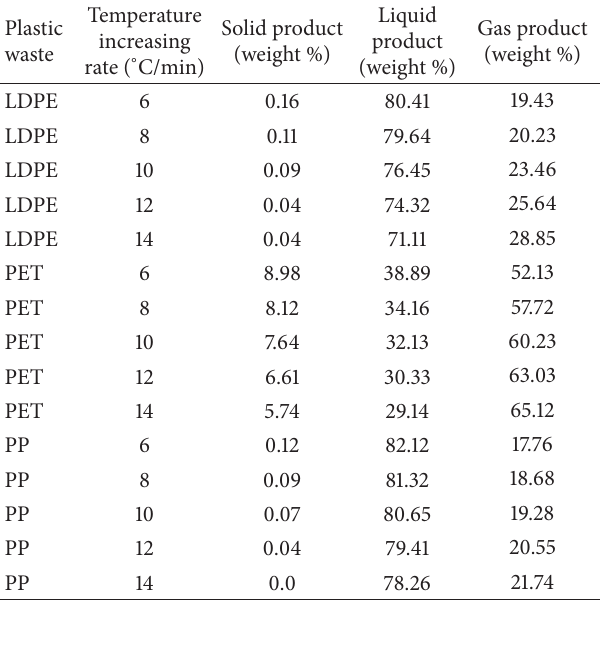
Table 3: Results of pyrolysis reaction at different temperature increasing rates and raw materials.